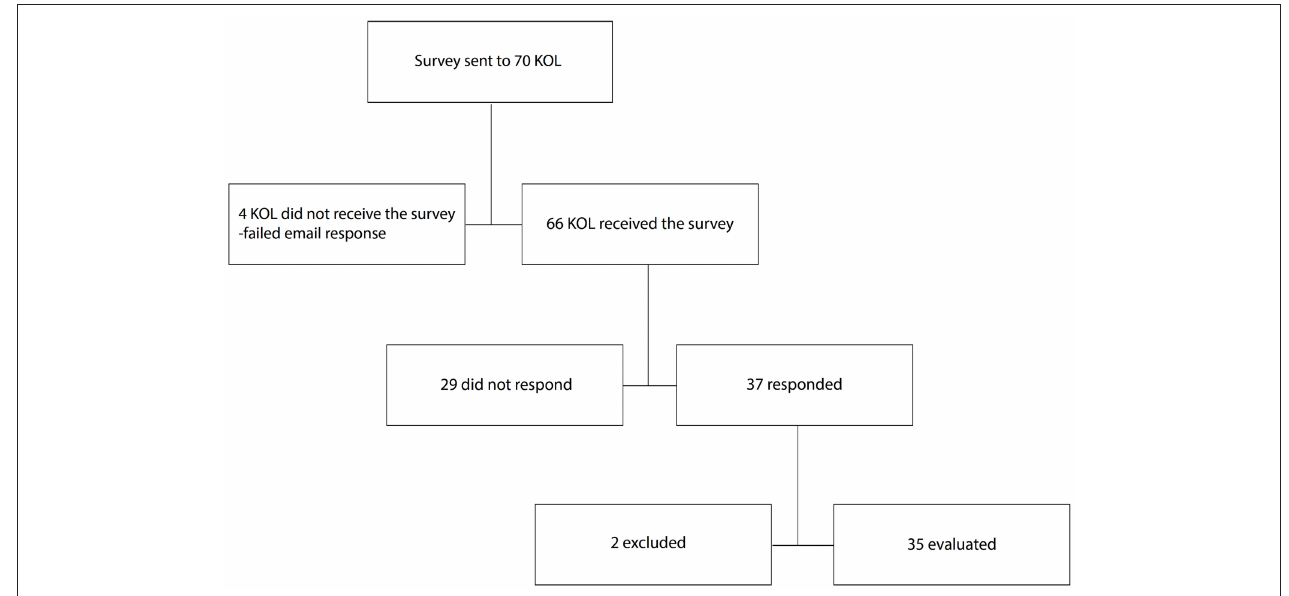
FIGURE 1 | Response